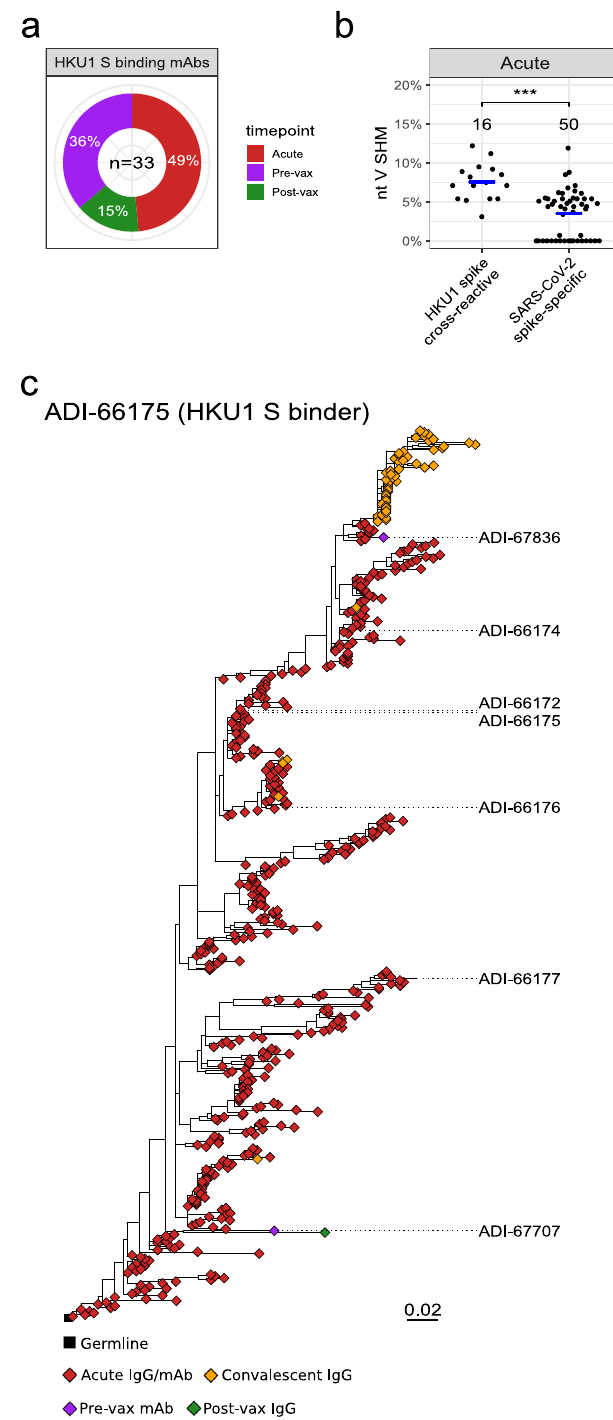
Fig. 3 | Isolation timepoints and evolution of HCoV-HKU1 S-cross-reactive mAbs. a Pie chart of timepoints at which HCoV-HKU1 S-binding mAbs were iso- lated. b Dotplotof%nucleotide IGHV SHMfortheHCoV-HKU1S-cross-reactiveand SARS-CoV-2 S-speci fi c mAbs isolated at the acute timepoint. A two-sided Mann – Whitney U testwasusedforcomparison;***indicatesa P value<0.001,with the exact value being P value=1.261e-5. c Maximum-likelihood phylogenetic trees of HCoV-HKU1 S-binding traced lineage ADI-66175. The germline sequence was obtained from the IgBLAST-generated “ germline_alignment ” column of the sequence with the minimum IGHV SHM in the